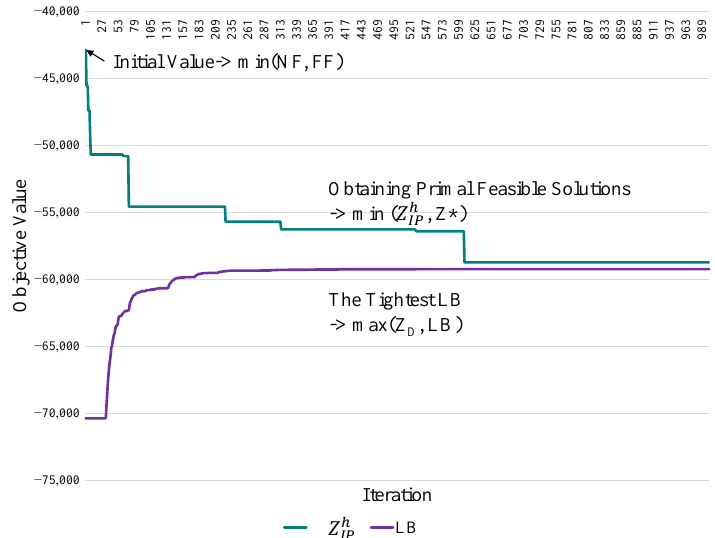
Figure 4. Obtaining primal feasible solutions and the tightest lower bound (LB). NF, next-fit.